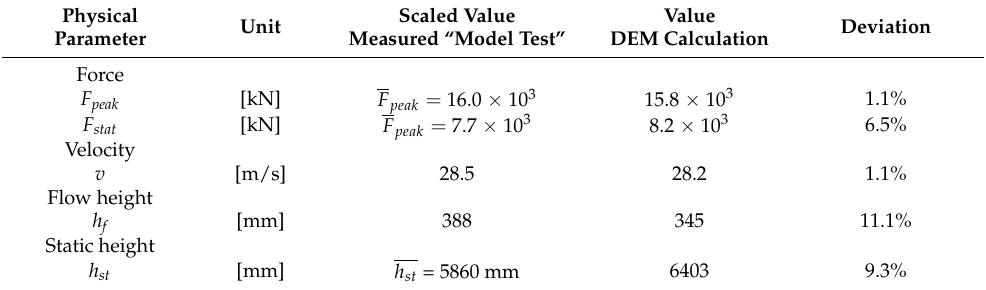
Table 10. Comparison of the scaled model results with the results of the scaled DEM